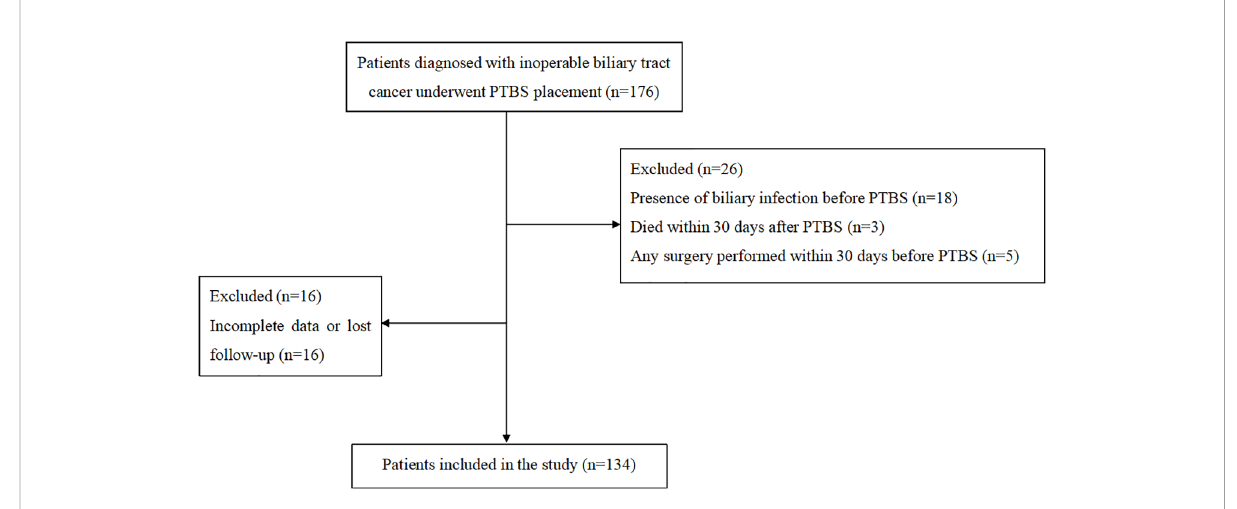
FIGURE 2 The fl ow chart of protocol in the